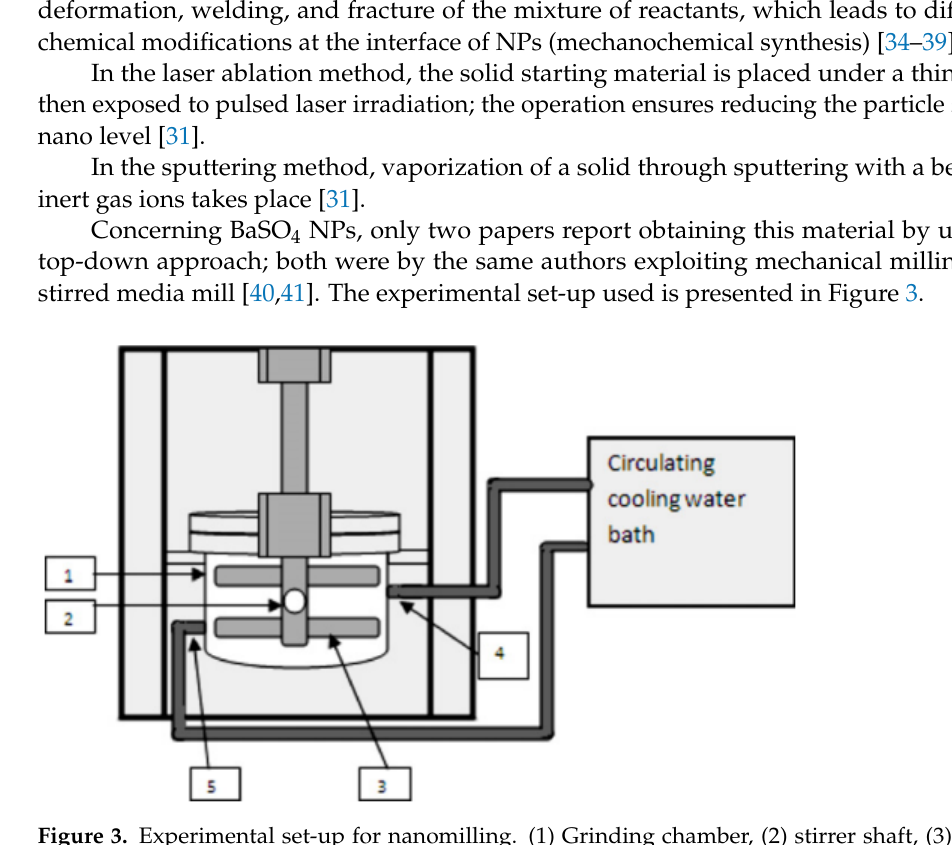
Figure 3. Experimental set-up for nanomilling. (1) Grinding chamber, (2) stirrer shaft, (3) stirrer pins, (4) cooling water in, (5) cooling water out. Reprinted with permission from ref. [40]. Copyright 2012 Elsevier.